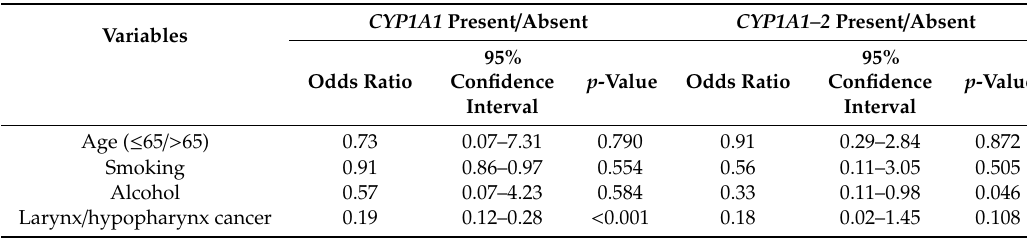
Table 6. Logistic regression model for “ CYP1A1 polymorphisms present / absent” and “ CYP1A1–2 polymorphisms present /